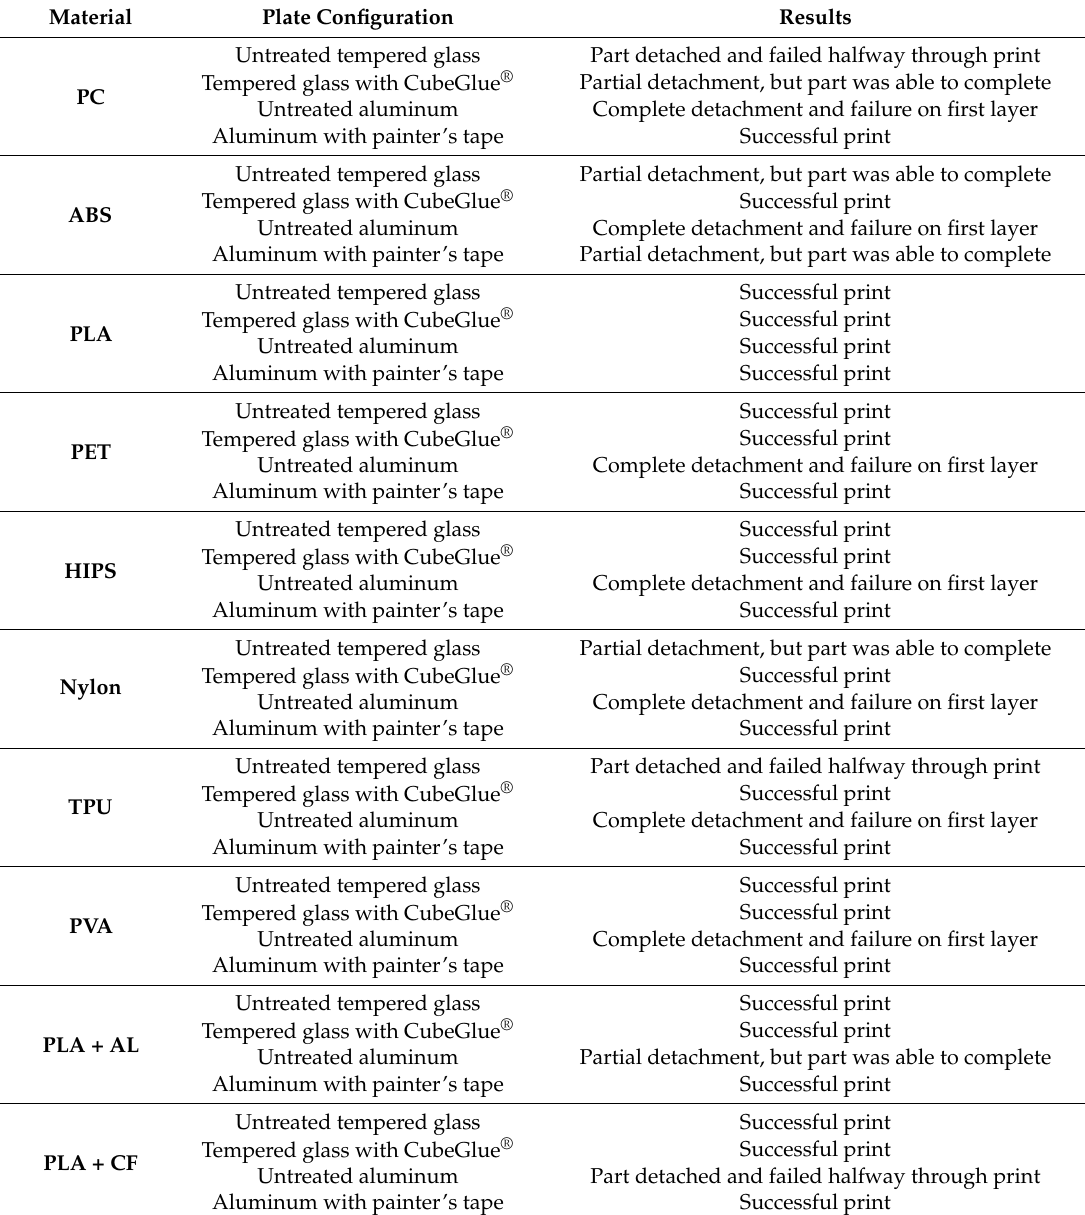
Table 6. Setup and results of printability